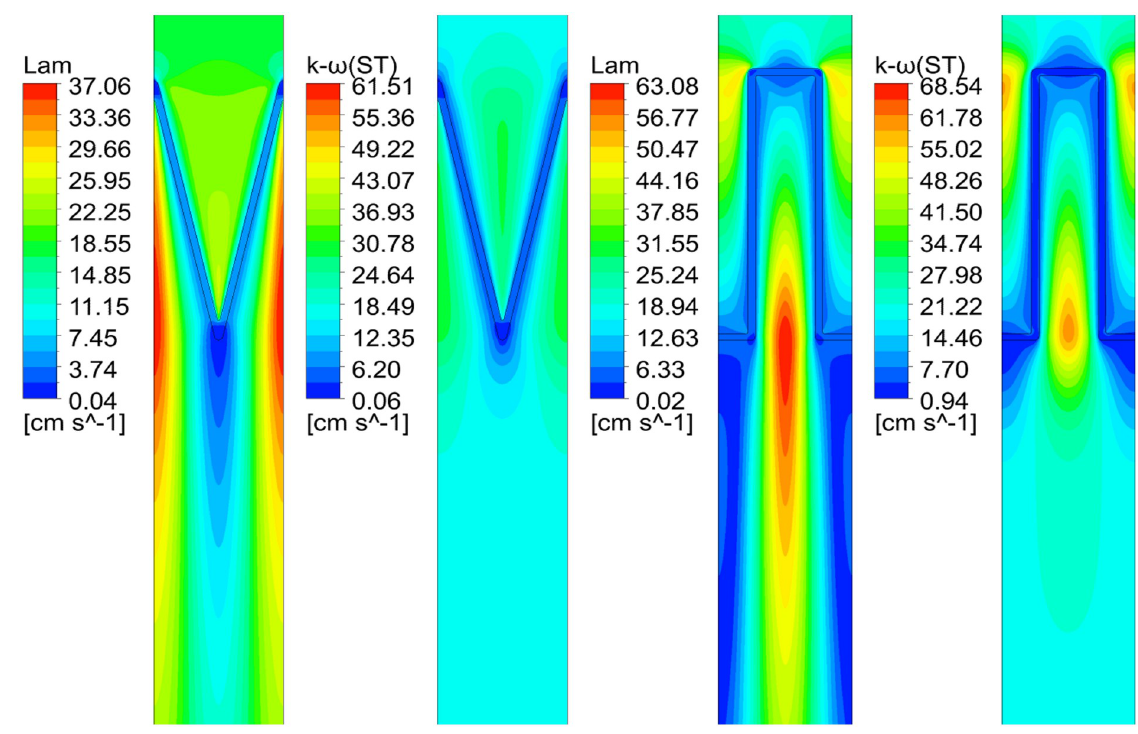
Fig 9. Velocity fields under different CFD models when α =